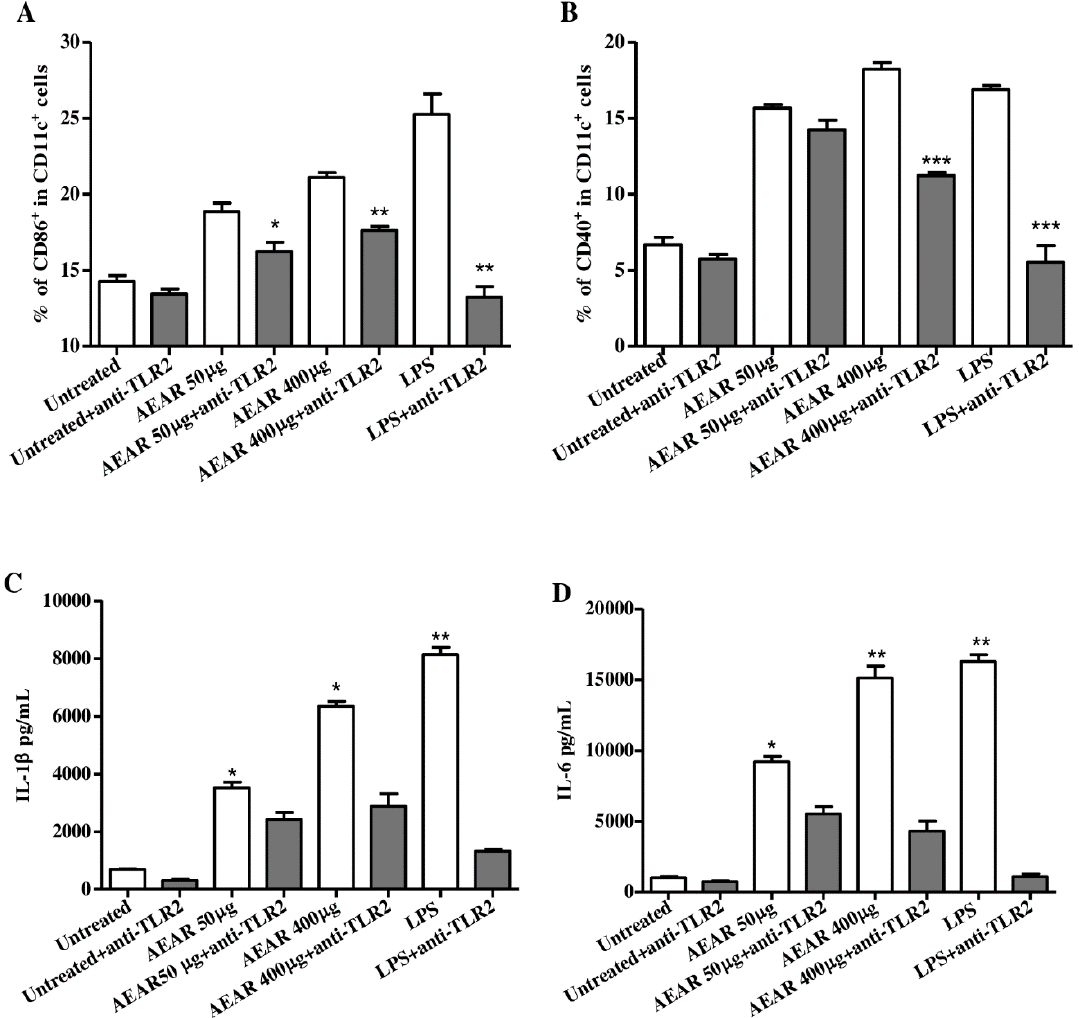
Figure 7. TLR2 ‐ dependent activation of DCs by AEAR. The activation of DCs was blocked by anti ‐ TLR2 antibody. ( A–B ) Expression levels of CD86 and CD40. ( C–D ) Production of IL ‐ 1 β and IL ‐ 6. The values are expressed as means ± SD (n = 3). * p < 0.05, ** p < 0.01, and *** p < 0.001 indicate significant differences compared with the group treated by AEAR alone, determined by one ‐ way analysis of variance (ANOVA) and Tukey’s multiple ‐ comparison test.